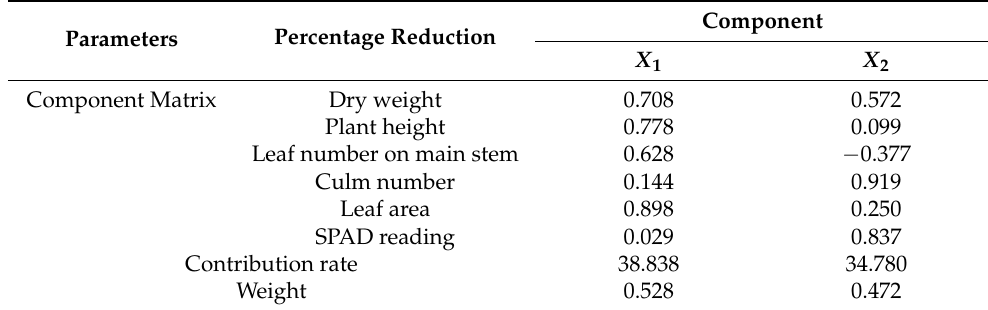
Table 5. Component matrix of the percentage reduction in agronomic traits and the contribution rate and weight of the components based on principal component